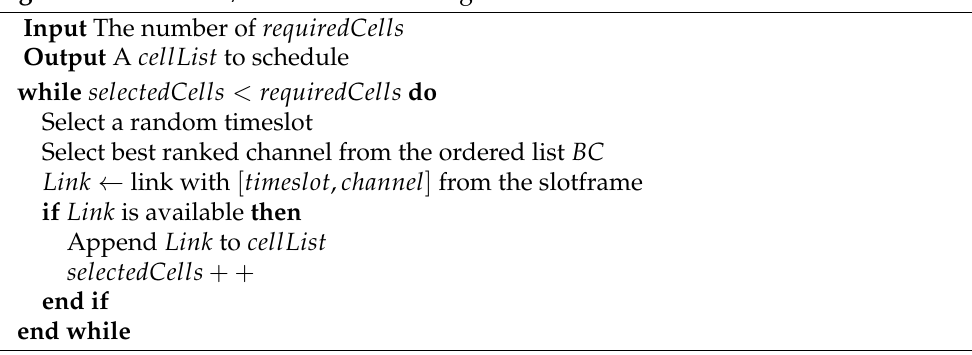
Algorithm 2 Timeslot/channel selection